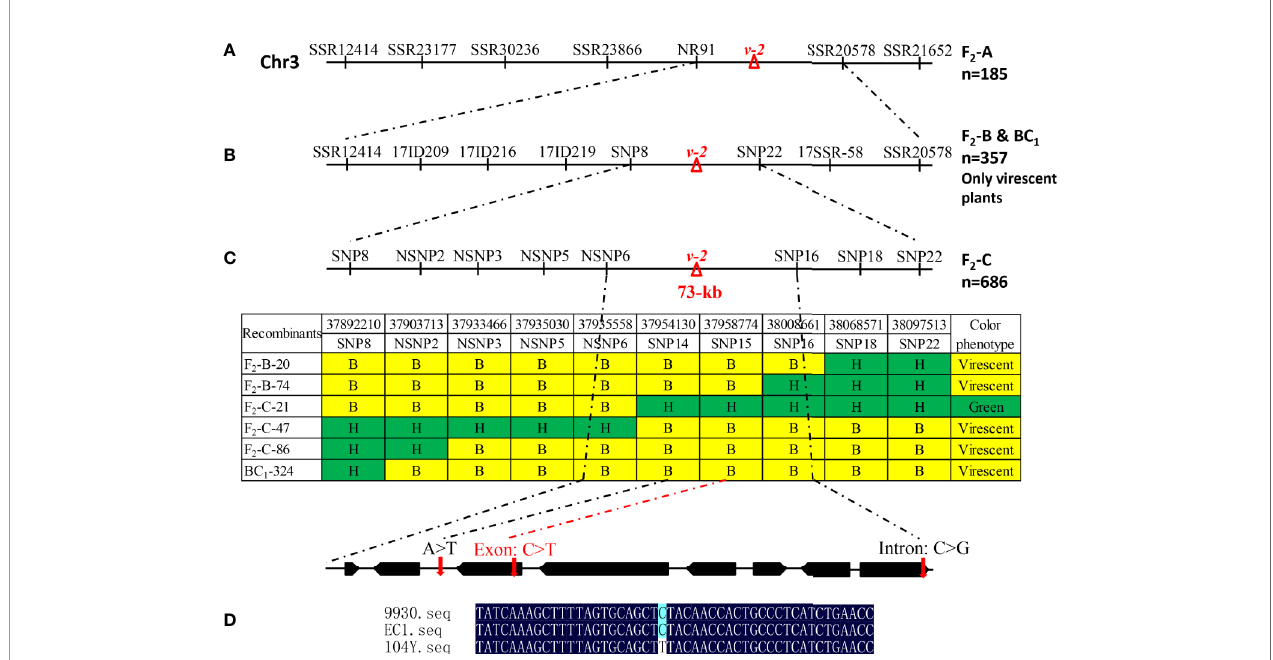
FIGURE 5 | Fine mapping of virescent leaf color ( v-2 ) locus. (A) Initial mapping with 185 F 2 -A plants placed v-2 between NR91 and SSR0578. (B) Fine mapping with 249 virescent plants in the F 2 -B population and 108 virescent plants in the BC 1 population narrowed down the v-2 locus into 116 kb DNA region between markers SNP8 and SNP16. (C) Further fi ne mapping with 686 F 2 -C plants delimited v-2 locus into 73 kb genomic region including eight genes. (D) As compared with EC1 and 9930, a single nucleotide substitution resulted in amino acid change in the gene Csa3G890020 in the 104Y.